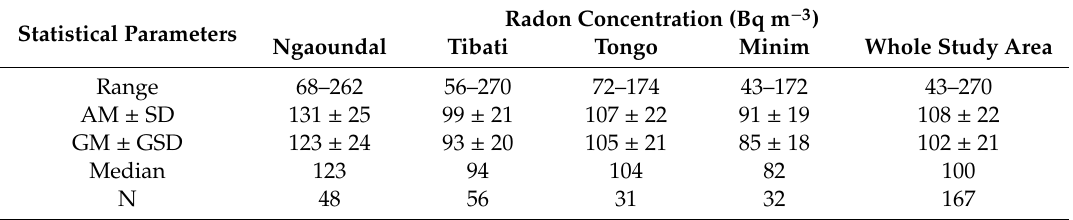
Table 1. Activity concentrations of 222 Rn determined by using Radon Track (RADTRAK)